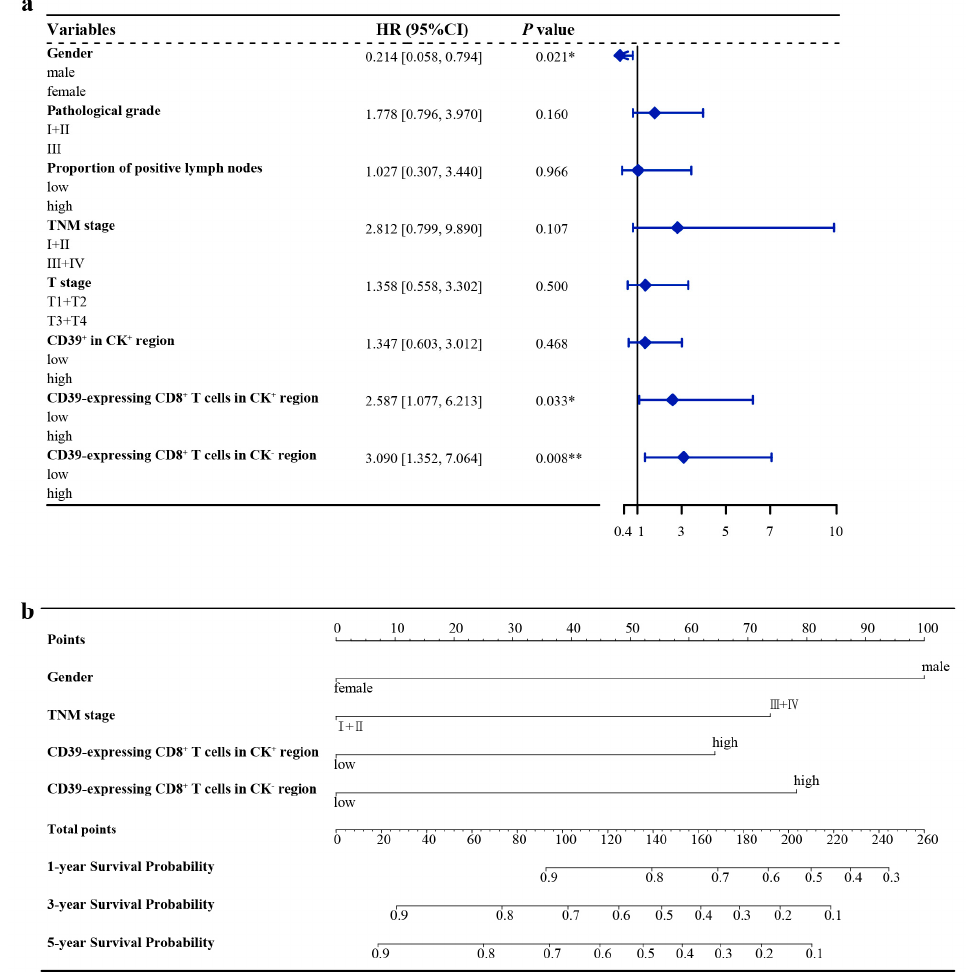
Figure 3. Hazard ratio of ESCC in the training group and nomogram model for OS of ESCC. ( a ) Hazard ratio of ESCC in the training group; ( b ) Nomogram model for OS of ESCC. CD39, ectonucleoside triphosphate diphosphohydrolase 1; CI, confidence interval; CK, cytokeratin; ESCC, esophageal squamous cell carcinoma; HR, hazard ratio; OS, overall survival. * p < 0.05, ** p < 0.01.